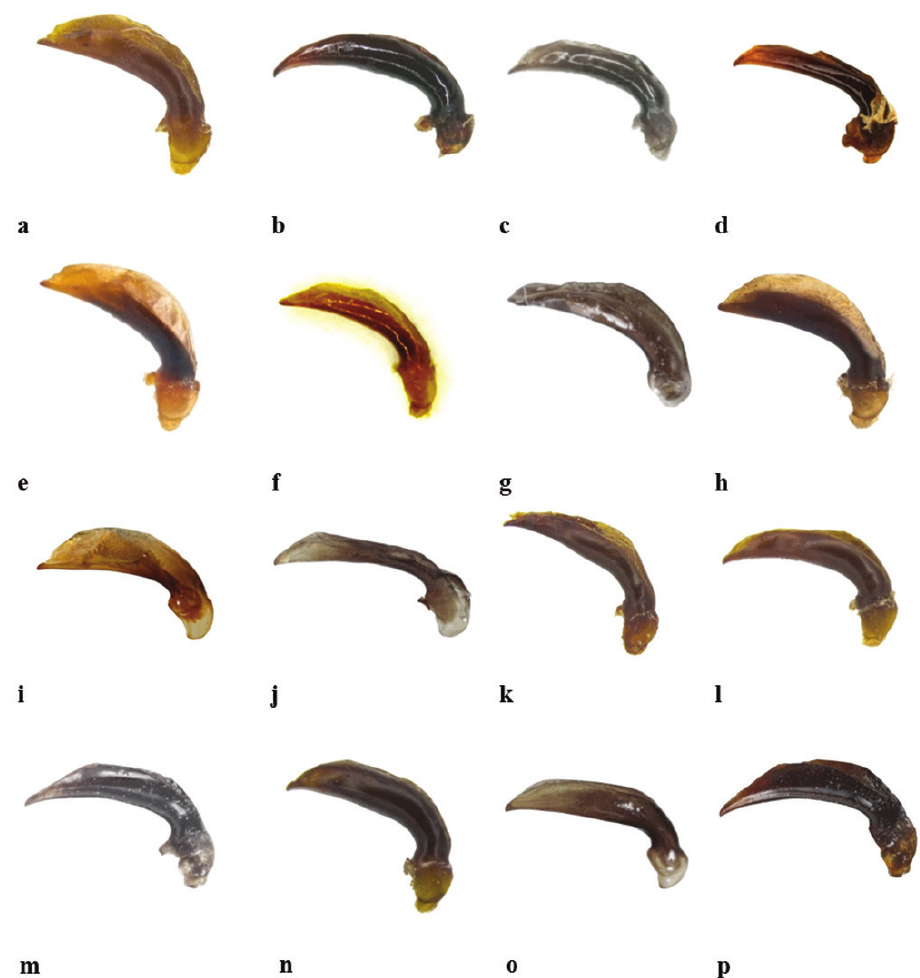
Figure 9. Median lobes of aedeagus: a G. barthelemyi b G. heydeni c G. luctuosus d G. magnus sp. n. e G. mauretensis sp. n. f G. minutus minutus g G. minutus goryi h G. multiguttatus i G. peletieri j G. piniamitai sp. n. k G. reymondi l G. rotundatus m G. serrator n G. sharonae sp. n., o G. stagonopsis sp. n. p G. valdanii .